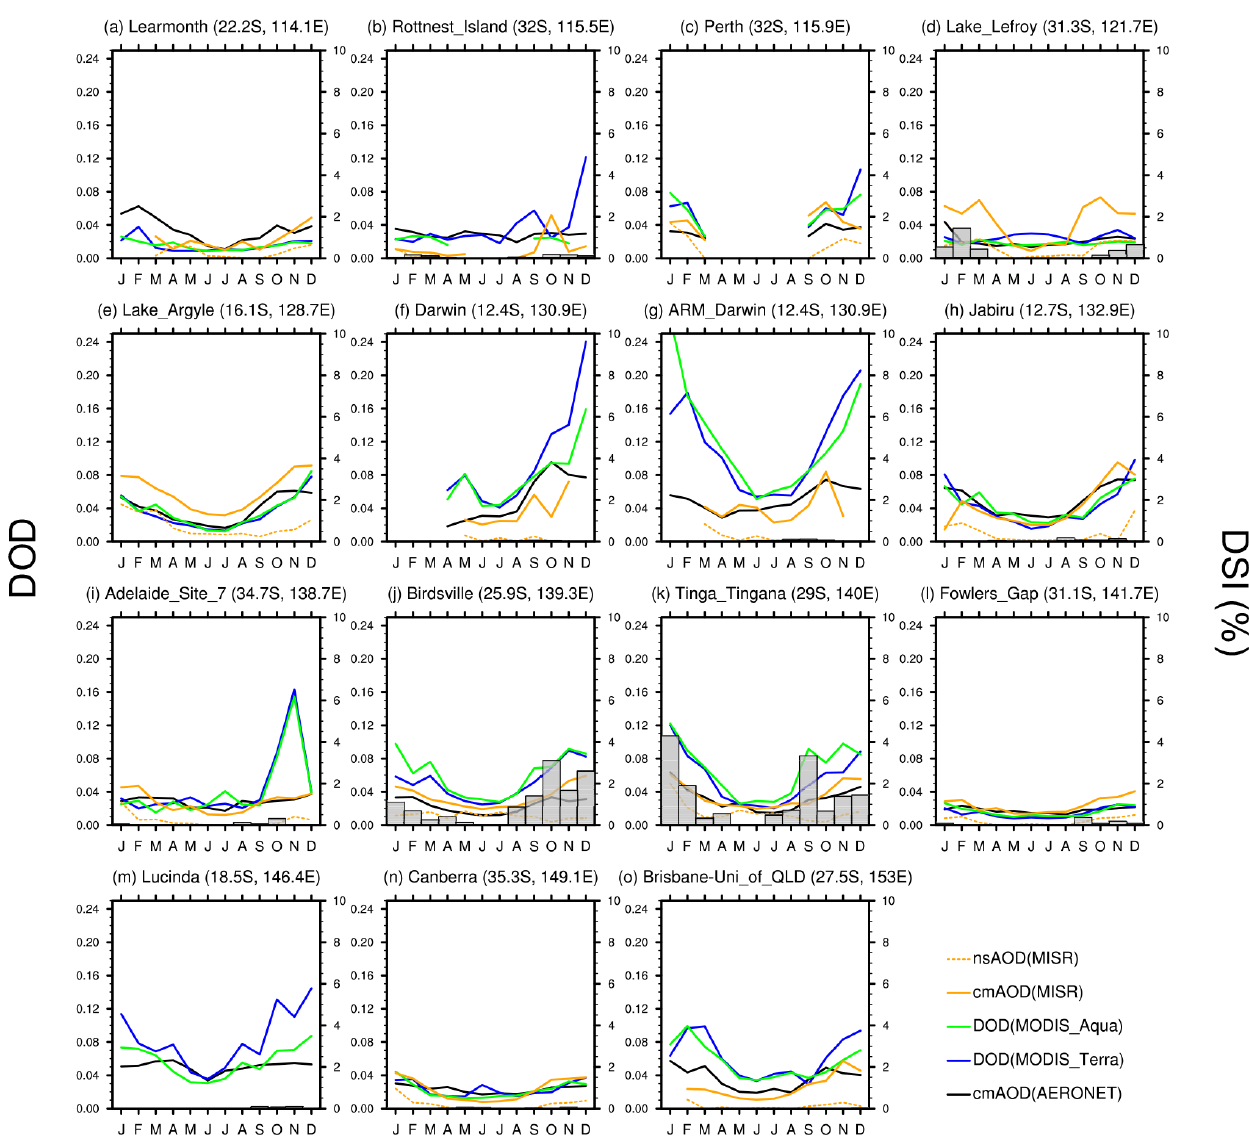
Figure 4. Seasonal cycle of dust activity at 15 AERONET sites in Australia. Lines represent mean DOD from MODIS-Terra (blue) and MODIS-Aqua (green), cmAOD from MISR (solid orange) and nsAOD from MISR (dashed orange), and cmAOD from AERONET (black) by month, referring to the left y axis. Bars, referring to the right y axis, represent mean DSI over weather stations located within 100km of each AERONET site. The seasonal cycle of dust activity from satellite and in-site observations is obtained from the active years of each AERONET site. The AERONET sites are presented by longitude from west to east, matching the letters in Fig.